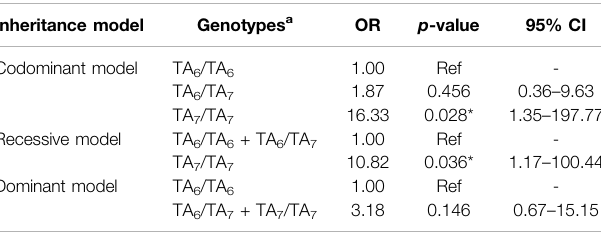
TABLE 4 | Univariate logistic regression between UGT1A1*28 (TA 7 ) and total bilirubin level > 1.9 mg/dl (moderate and severe hyperbilirubinemia) in patients treated with atazanavir.